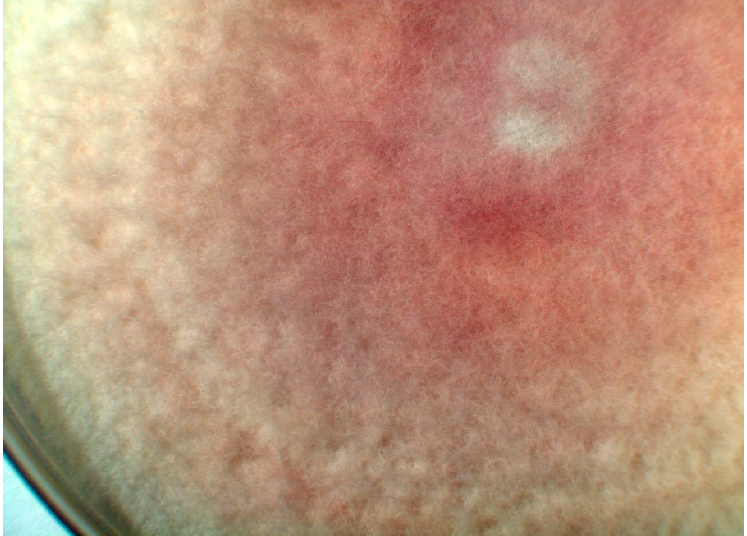
Figure 2. A floccose colony of Fusarium oxysporum on Sabouraud agar, seven days after incubation at 26 °C. The colonies themselves are white but they produce a red pigment, which is secreted into the surroundings. One sees the red color of the agar shining through. (Magnification 10×)